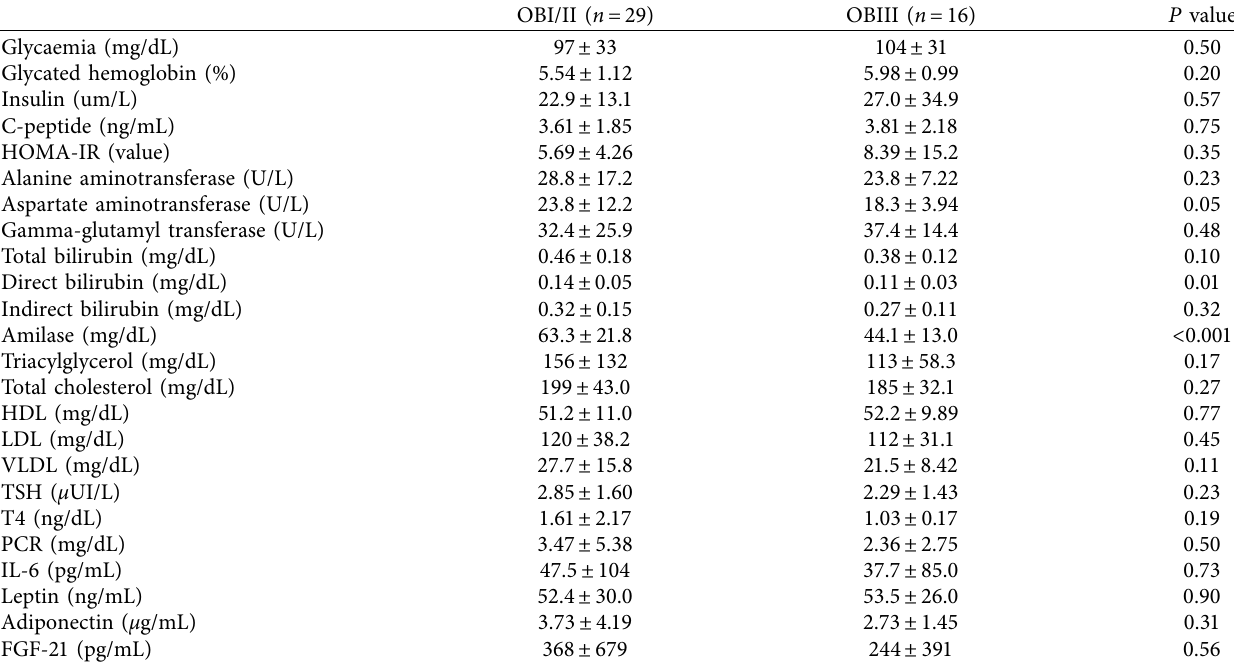
Table 4: Biochemical data.